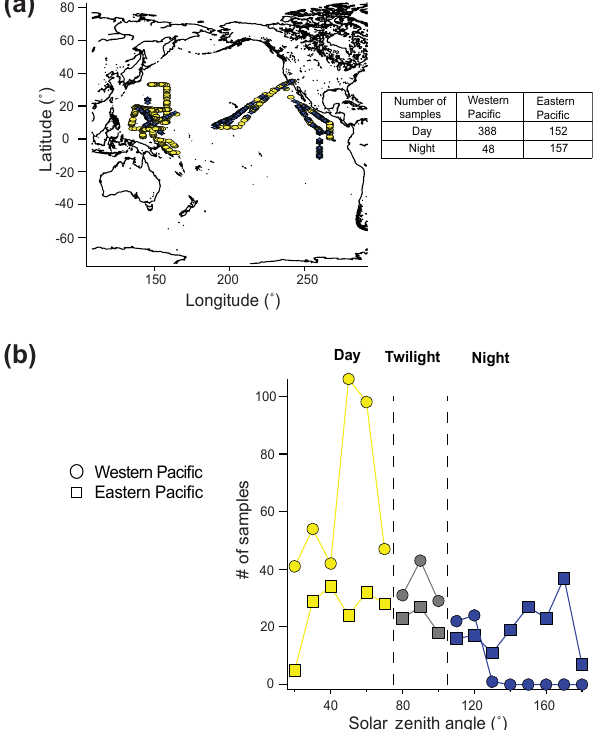
Figure 1. (a) Location of GWAS observations along ATTREX flight tracks taken at different altitudes over the WP and EP. Yellow filled circles represent the samples taken during the day and blue filled circles the samples taken at night. (b) Sample density of GWAS observations arranged by solar zenith angle over the western and eastern Pacific. Yellow filled circles represent samples taken over the WP during daylight, while blue filled circles are the samples taken over the WP during nighttime. Yellow filled squares represent the samples taken over the EP during daylight, while blue filled squares are the samples taken over the EP during nighttime. Grey circles and squares are the samples taken during twilight over the WP and EP,